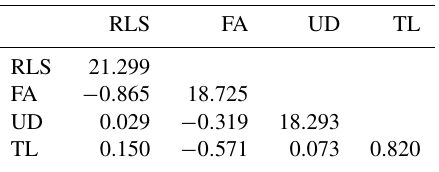
Table 4. Estimated phenotypic variances (diagonal) and covari- ances (below diagonal).